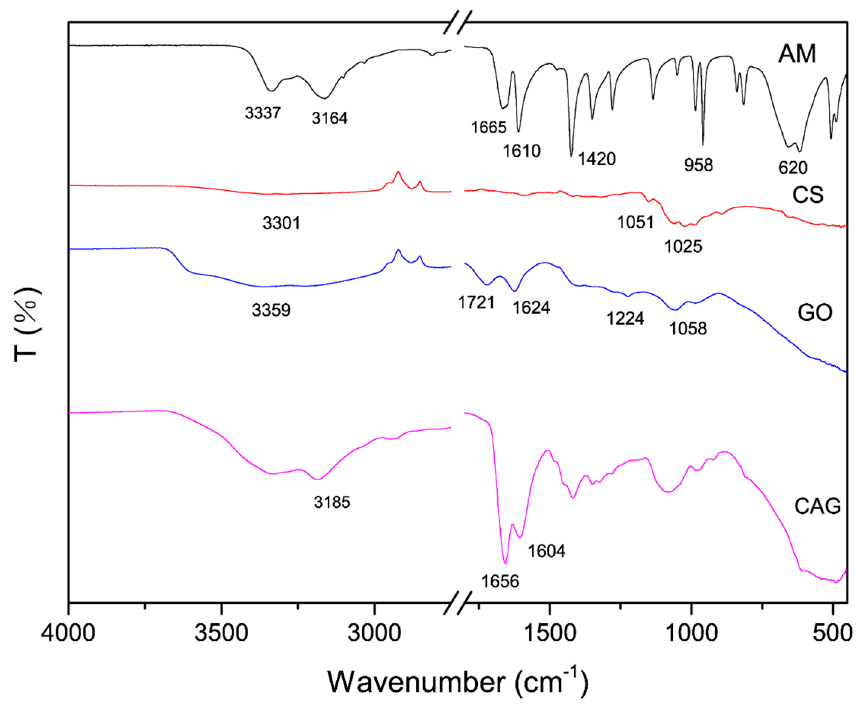
Figure 4. FT-IR spectra of AM, CS, GO, and CAG-GO20%.